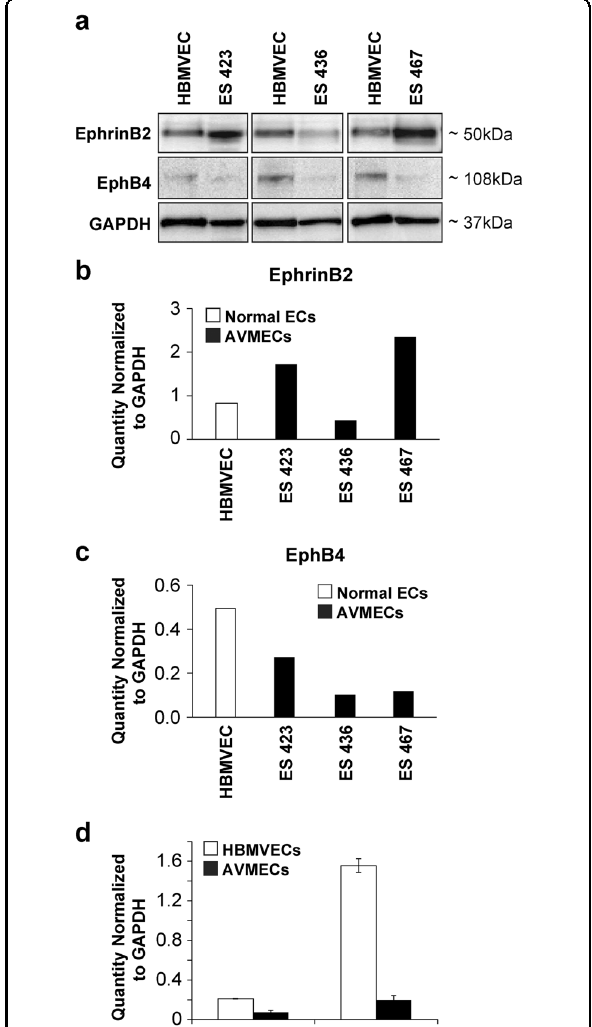
Fig. 2 The ratio of EphrinB2 to EphB4 is altered in pathologic AVMECs at both the mRNA and protein levels. a – d Relative to control cells, the ratio of relative EphrinB2 to EphB4 is increased in AVMECs. a Western blot analysis demonstrated increased EphrinB2 and decreased EphB4 levels in AVMECs compared to those of normal HBMVEC controls. b On average, AVMECs express higher levels of EphrinB2, following normalization to GAPDH. c AVMECs express lower levels of EphB4, following normalization to GAPDH. d At the mRNA level, HBMVECs express higher levels of both EphrinB2 (threefold) and EphB4 (eightfold) at the mRNA level and a >3-fold higher ratio of EphB4 to EphrinB2 than what is observed in control